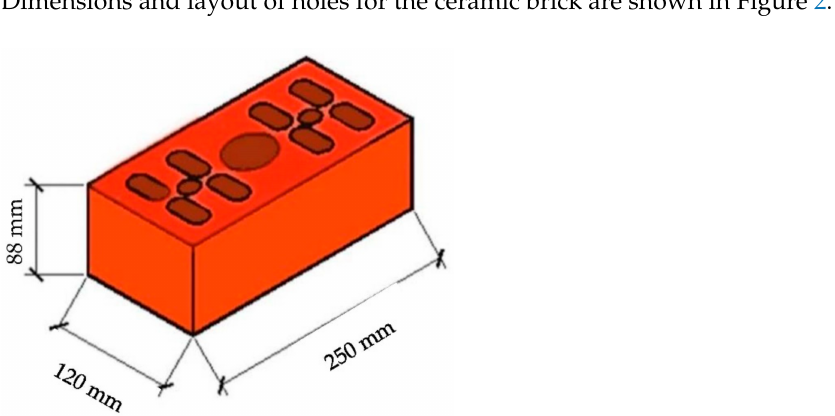
Figure 2. Dimensions and layout of holes for ceramic brick class M12.5 (FCP, Brest, Belarus) used in the